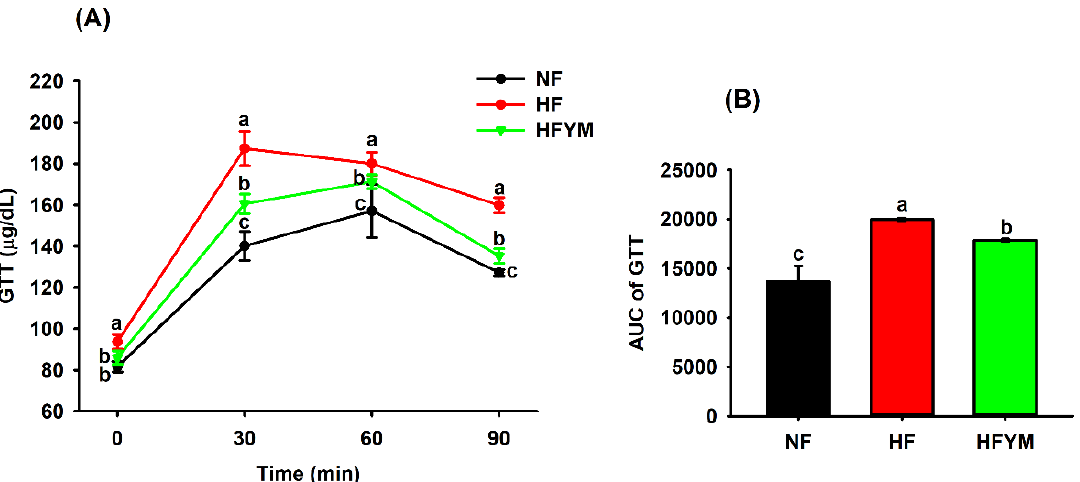
Figure 4. Glucose tolerance test (GTT) ( A ) performed in the rats fed a normal-fat or high-fat diet and supplemented or not with yellow mombin, as well as the area under the curve of (GTT AUC) of GTT ( B ). NF = normal-fat diet; HF = high-fat diet group; HFYM = high-fat diet group supplemented with yellow mombin. Data are represented with mean ± standard deviation. (a, b, c) = Different lowercase letters at the same time or in the bars indicate that there was a statistical difference among the groups (one way ANOVA followed by Tukey’s post-test, p ≤